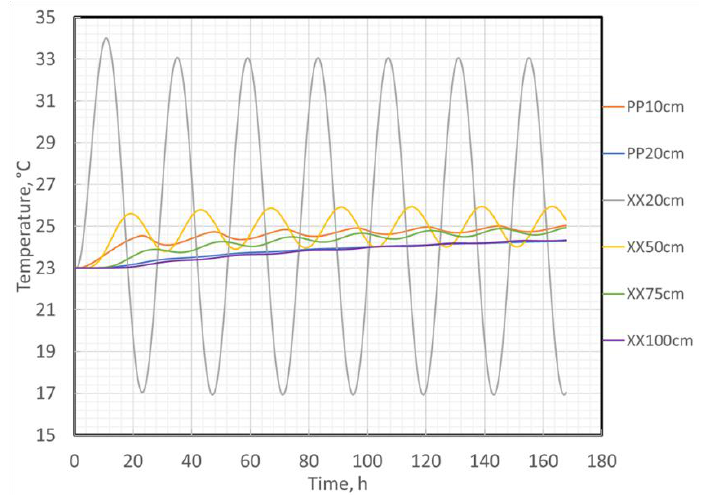
Figure 15. The internal temperature variation with different wall configurations. P stands for PCM;